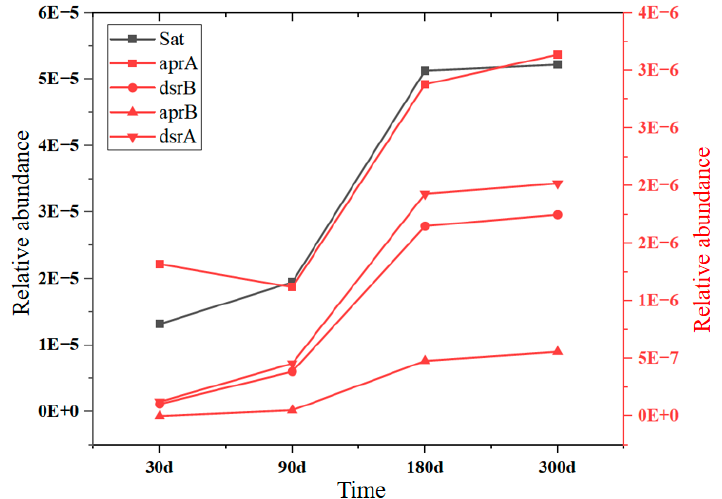
Figure 11. Variation characteristics sulfate reductive metabolic genes.